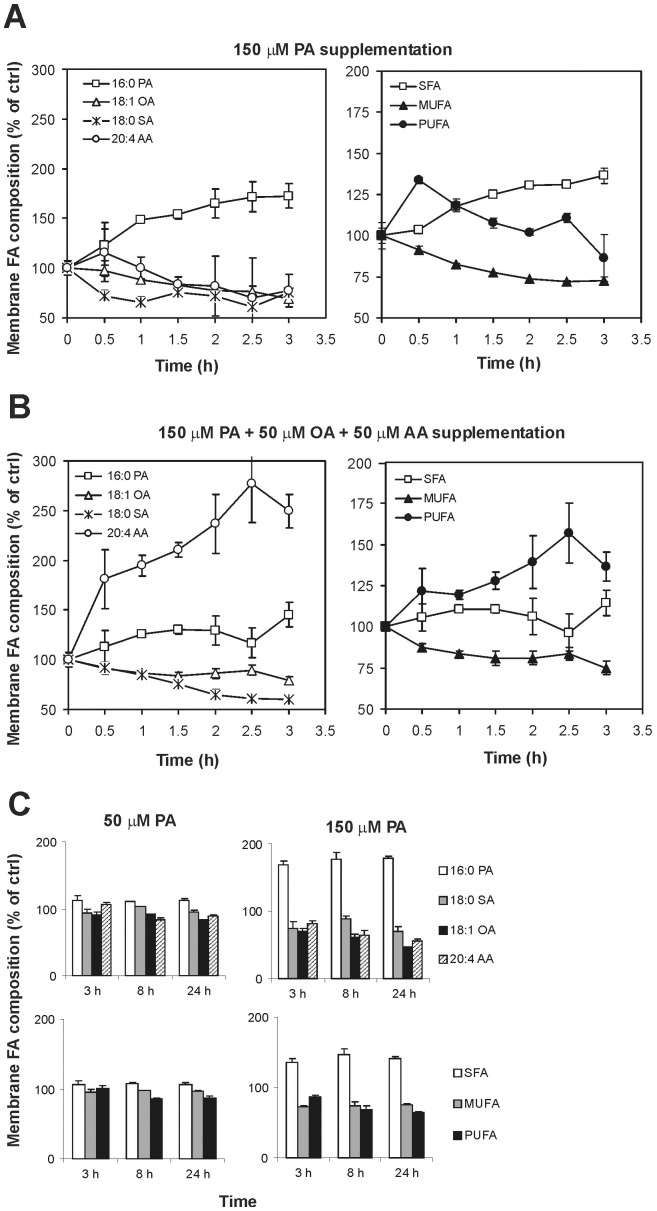
Main fatty acid changes in NB100 cell membranes after fatty acids supplementation.(A) In the left panel, the main fatty acid variations in NB100 cell membranes after 150 µM PA supplementation are reported. In the right panel, fluctuations of the corresponding fatty acid families are evidenced. (B) In the left panel, the main fatty acid variations in NB100 cell membranes after 150 µM PA +50 µM OA +50 µM AA supplementation are reported. The right panel evidences the fatty acid family changes after this supplementation. (C) In the left panel, the main fatty acid variations and the corresponding fatty acid families are evidenced in NB100 cell membranes after 50 µM PA supplementation. In the right panel, the same fatty acid variations are reported for cells incubated with 150 µM PA for 8 hours and 24 hours. Data are obtained from Tables 1, 2 and 3. Values are means ± SD. Statistical significances are as reported in the notes to the tables.